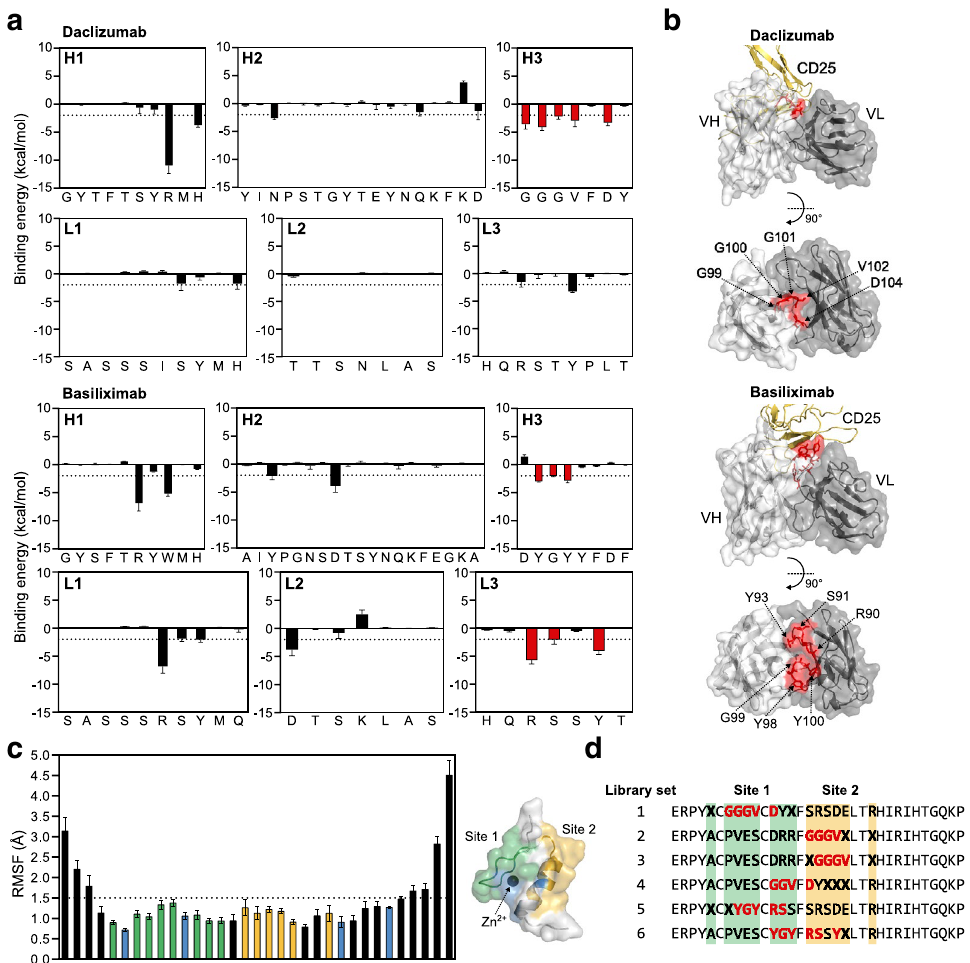
Figure 2. Antibody-guided design of the Zif-FLAP candidate library. ( a ) Identification of CD25-binding residues on CDRs of daclizumab and basiliximab. The binding free energy of each CDR residue to CD25 was calculated and is shown as the mean ± SEM obtained by averaging the values from the final 1 ns of three replicate 50-ns production runs. Bars in red represent residues with binding free energy values of < − 2 kcal/mol and that belonged to CDRs with three or more such residues. ( b ) Structures and molecular surface representations of the variable regions of daclizumab and basiliximab light (VL) and heavy (VH) chains. CD25 is shown in yellow, while the CD25-binding residues selected in ( a ) are depicted as the stick representation in red. ( c ) RMSF profile (left) and structure and molecular surface representation (right) of Zif. The mean ± SEM values from three replicate 100-ns production runs are shown. Bars in blue represent zinc-coordinating residues, while those in green and yellow represent residues that comprise sites 1 and 2, respectively. Sites 1 and 2 are highlighted on the structure in green and yellow, respectively. The zinc ion (black sphere) coordinated by the two cysteine and histidine residues (blue; in stick representation) is also shown. ( d ) Zif-FLAP candidate library design. The final library consisted of six library sets, four of which were designed on the basis of daclizumab, while the remaining two were designed on the basis of basiliximab. Mutated residues are shown in bold with residues in X representing those that were fully randomized and those in red representing the CD25-binding residues identified in ( a